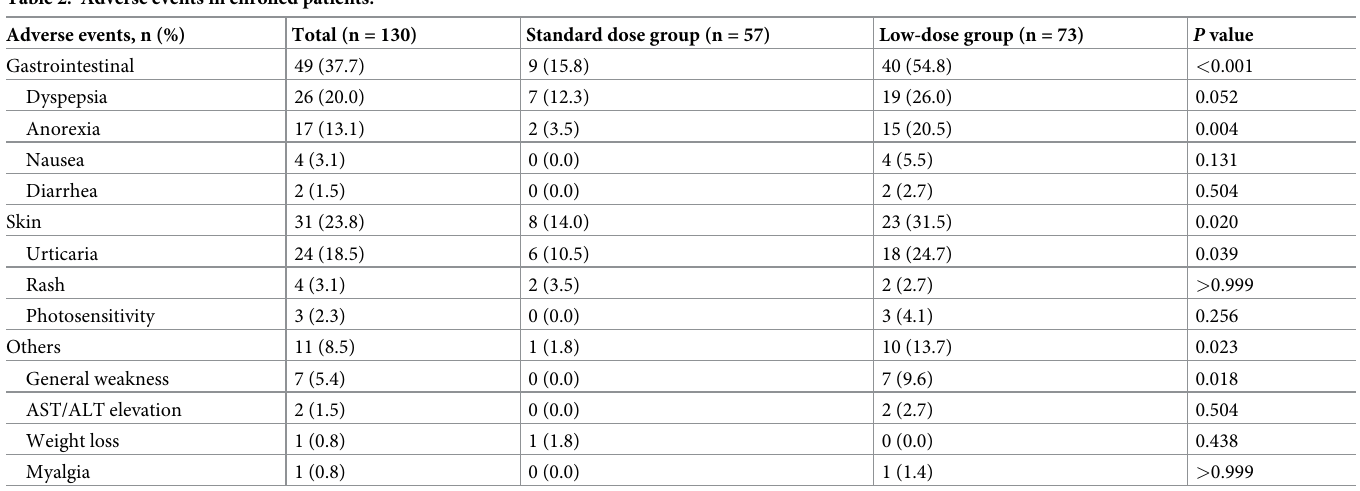
Table 2. Adverse events in enrolled patients.